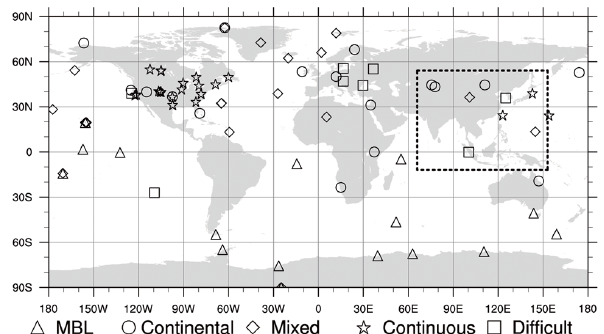
Figure 3. Observation network of CO 2 concentrations around the globe and the nested domain of the TM5 transport model over Asia (dashed box). Each observation site is assigned to different cate- gories ( (cid:52) : MBL; (cid:13) : Continental; (cid:5) : Mixed land/ocean and moun- tain; (cid:63) : Continuous; (cid:3) :